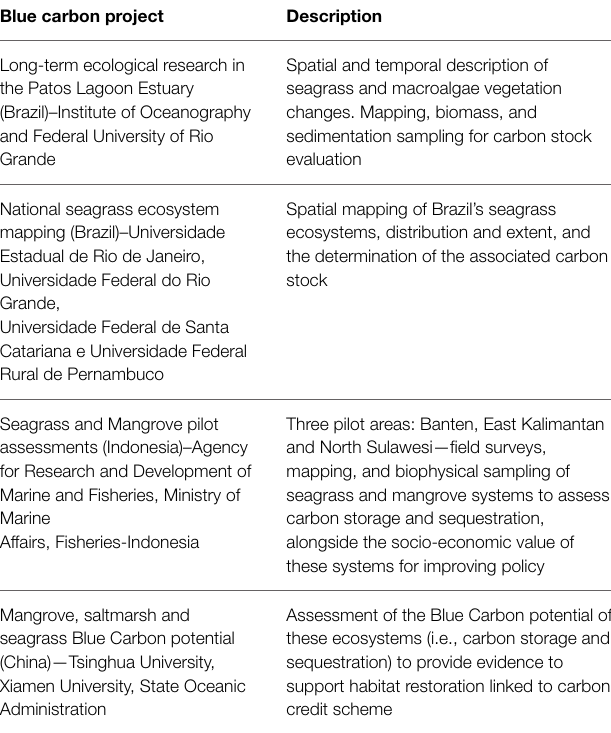
TABLE 5 | Seagrass-related blue carbon